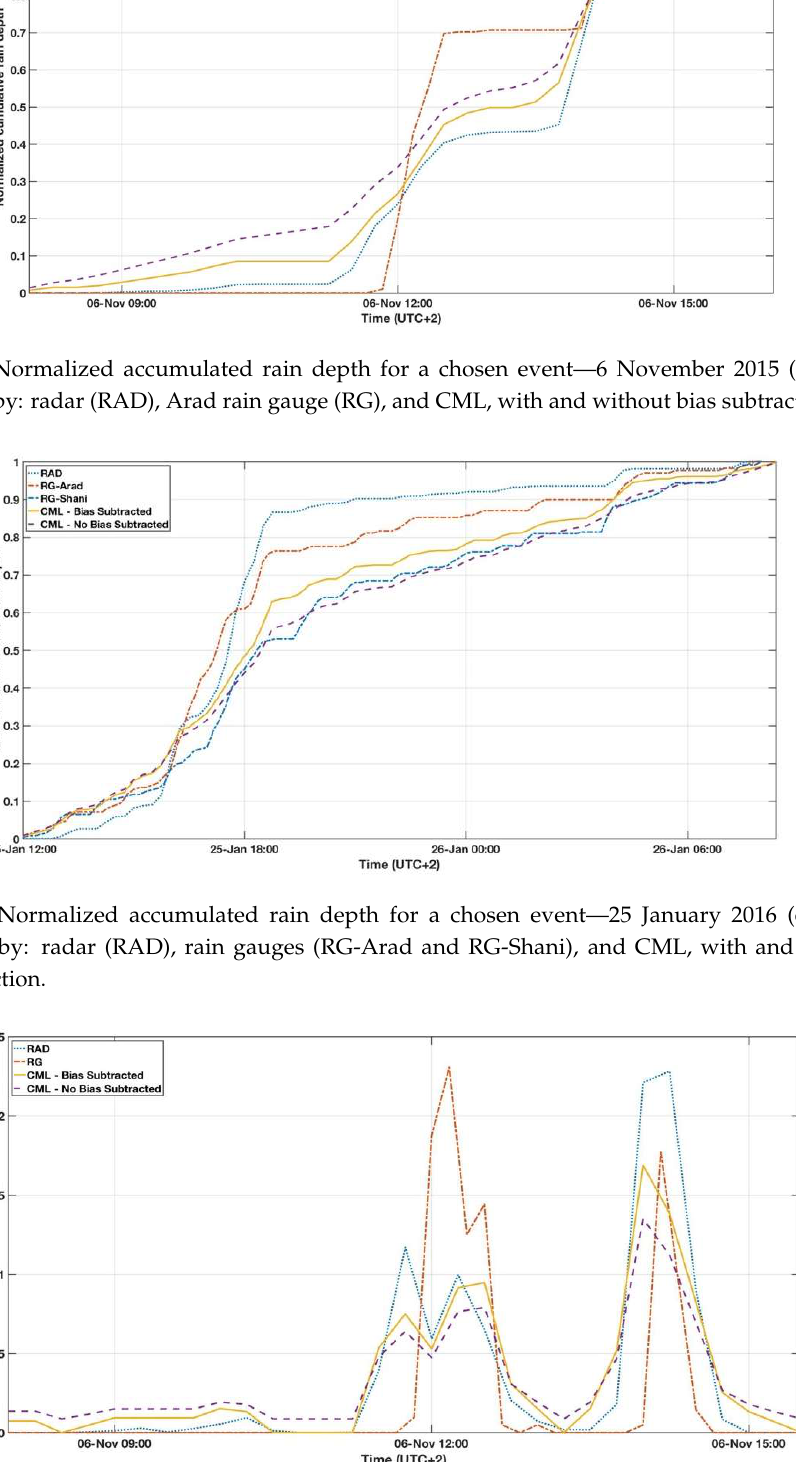
Figure 4. Normalized instantaneous rain intensity time series for a chosen event—6 November 2015 (event 1), monitored by: radar (RAD), Arad rain gauge (RG), and CML, with and without bias subtraction.